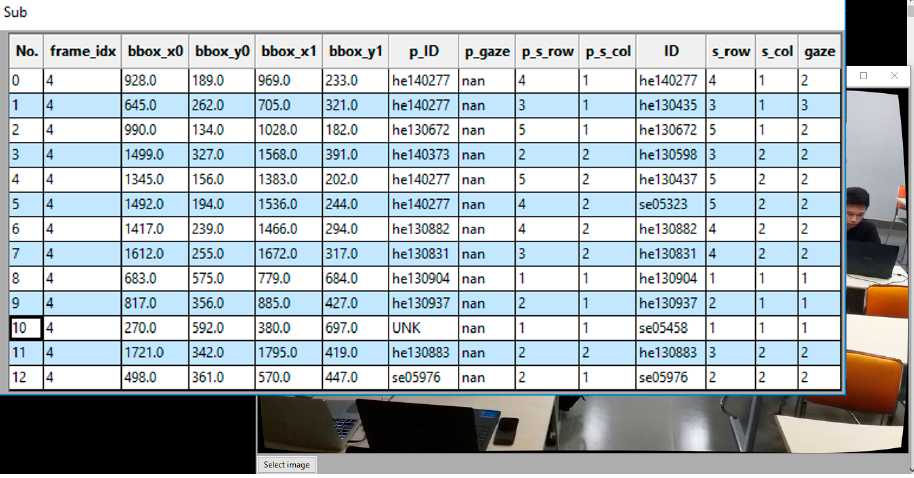
Figure 5. Label annotation tool: visualize window. Each row is labeled with parameters of students: student IDs, the seats of students in the classroom, and